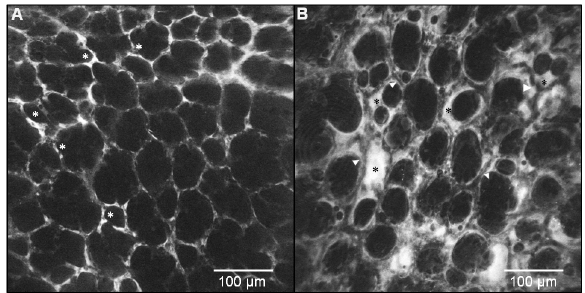
Figure 2. Video captures from a grey-scale video recording of ( A ) a healthy rat lung injected intravenously with a fluorophore (fluorescein)-labeled Dextran (i.e., vascular dye). In view, various filling of alveolar microcirculation (in white) showing capillaries keeping inside the dye (white asterisks). ( B ) A similar view of rat airspaces showing interstitial and alveolar edema after acute respiratory distress syndrome (ARDS) induced by 72 h hyperoxia. Heterogeneous levels of vascular dye leaking with partially/fully flooded airspaces (black asterisks), along with fully/partially empty capillaries (white arrows) [52]. Five 1™ (OptiScan) imaging.